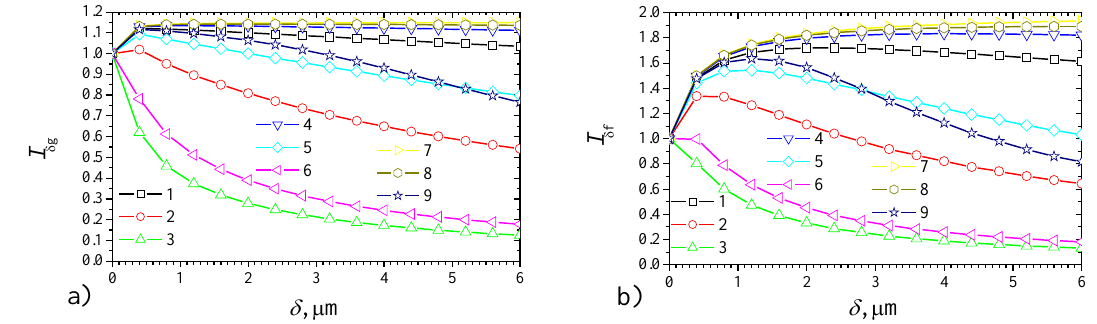
Figure 3 . The normalized steady state current vs. the thickness δ of the outer membrane in the cases of plate − gap (a) and flat (b) biosensors at three maximal enzymatic rates V (3, 6, 9) mM/s and three substrate concentrations S b = 2 a = 4 µ m, c = 4 µ m, d = c + δ .